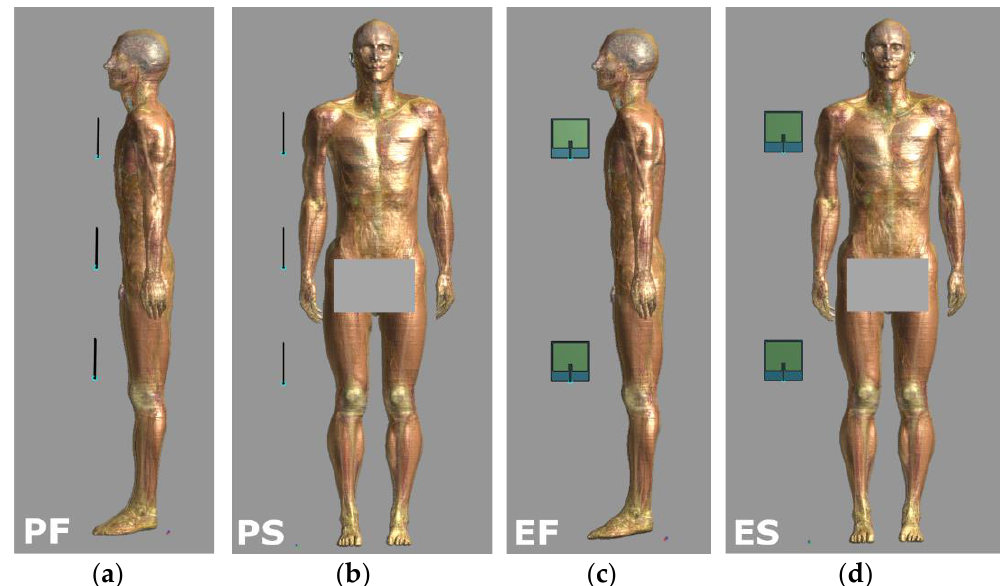
Figure 4. Exposure scenarios to EMF near UHFI-RFID multi-antennas readers: ( a ) three antennas plane in front of (PF) and ( b ) to the side of (PS); and ( c ) two antennas side-on in front of (EF) and ( d ) to the side of (ES) human body model.